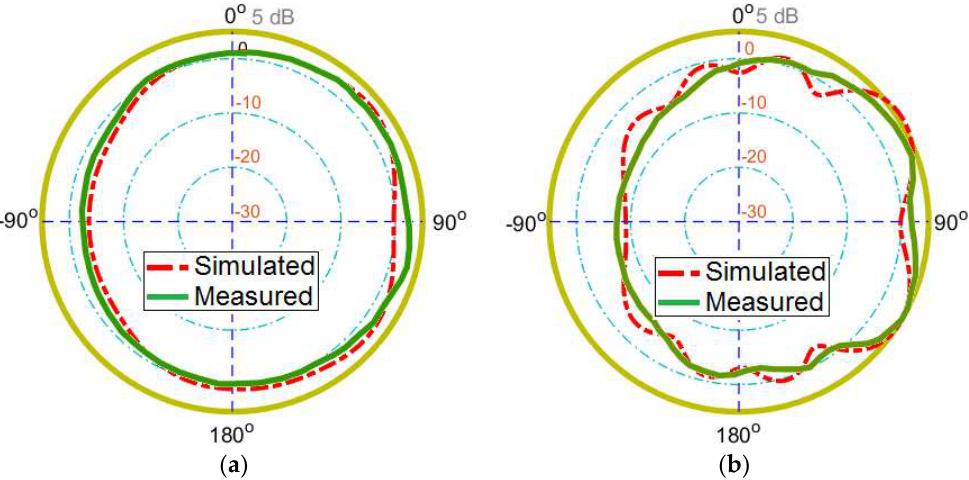
Figure 16. Measured and simulated 2D radiation patterns for ( a ) Ant.1 and ( b ) Ant.2.